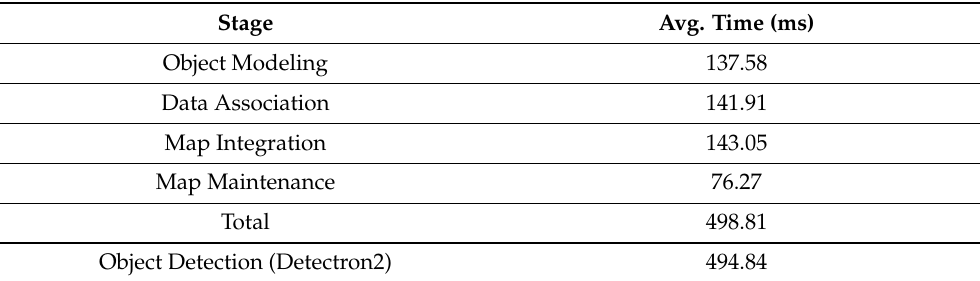
Table 3. Average computation time per frame for each of the key stages of LTC-Mapping with RGB-D input images of 640 × 480 resolution. Note that the object detection is computed in parallel to our pipeline and hence is not included in the total time of LTC-Mapping